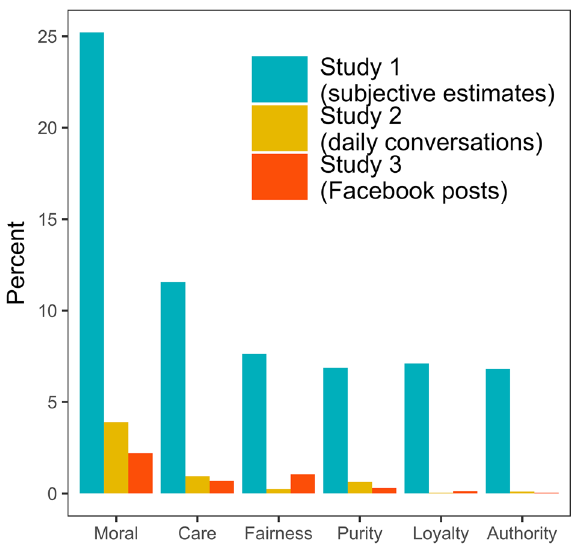
Figure 2. The estimate of moral concerns in all